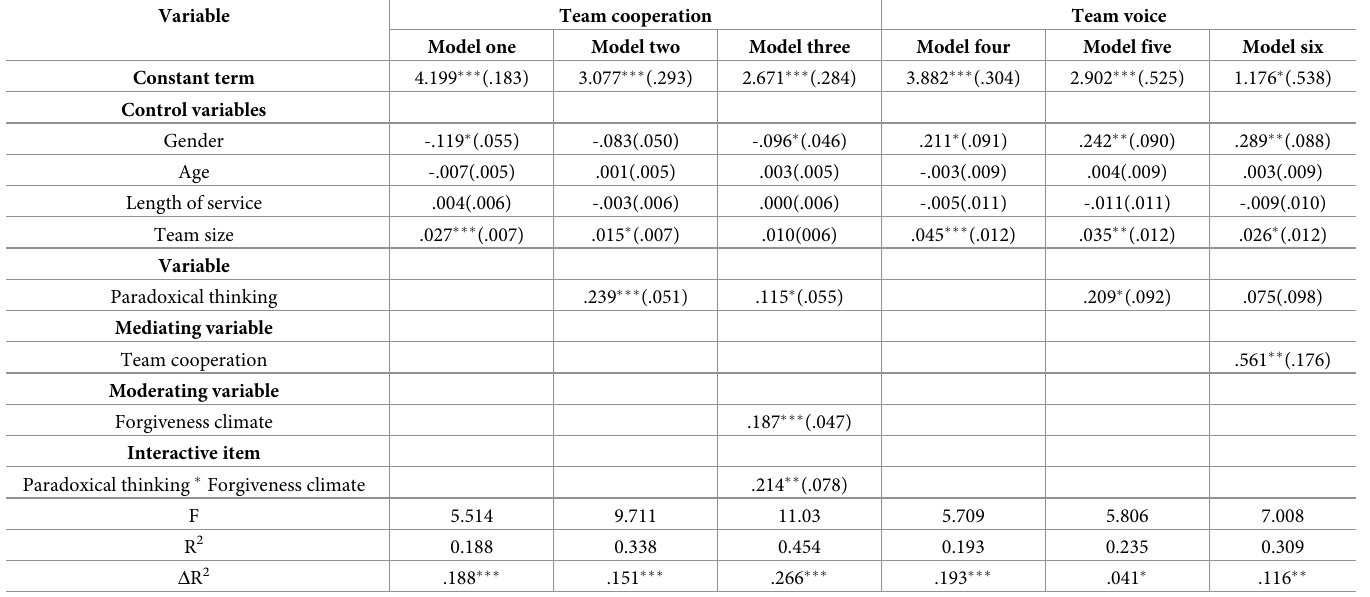
Table 3. Regression analysis